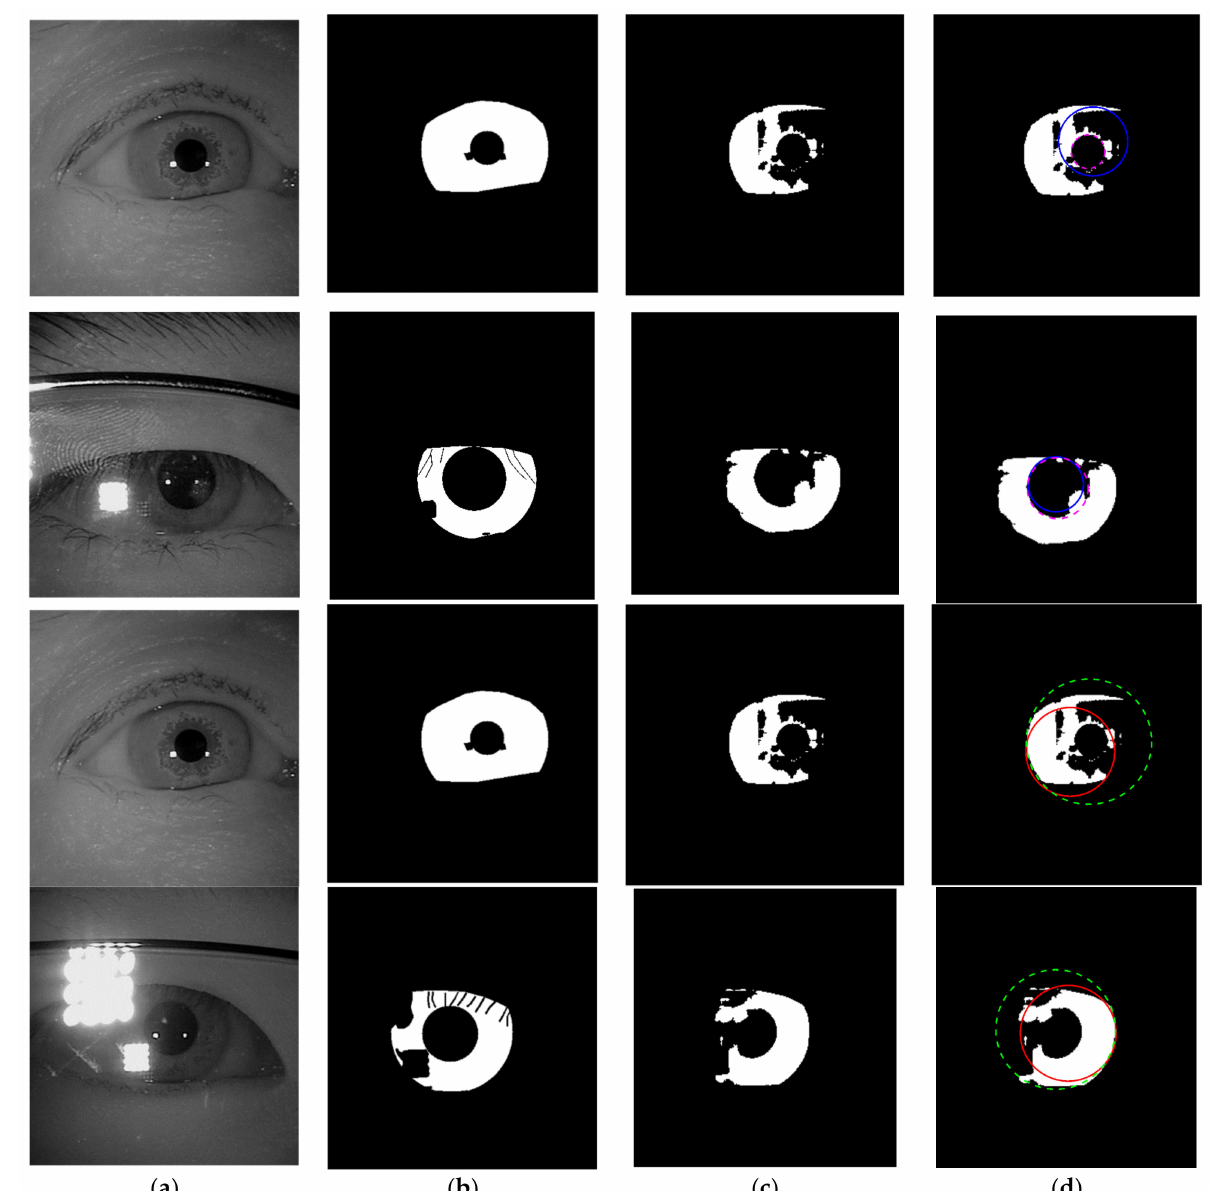
Figure 14. Failure cases because of the imperfect predicted masks. ( a ) Input images; ( b ) ground-truth masks; ( c ) predicted masks; ( d ) recover inner and outer boundary. The dashed lines denote the ground-truth and the solid lines denote the prediction. Row 1 and 2 show the result for inner boundaries and row 3 and 4 show the result for outer